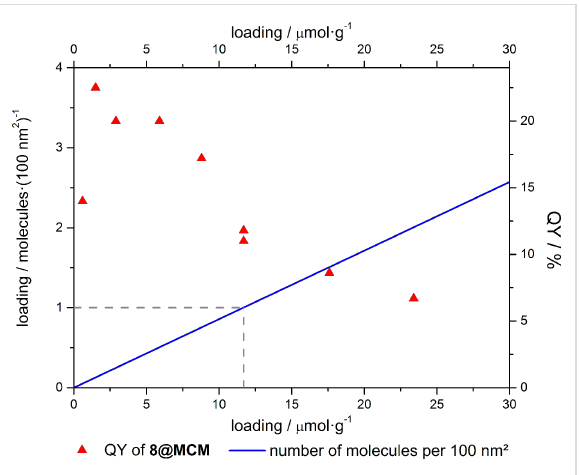
Figure 3: Number of molecules per 100 nm² and quantum yields of 8@MCM in relation to the loading of hybrid materials.